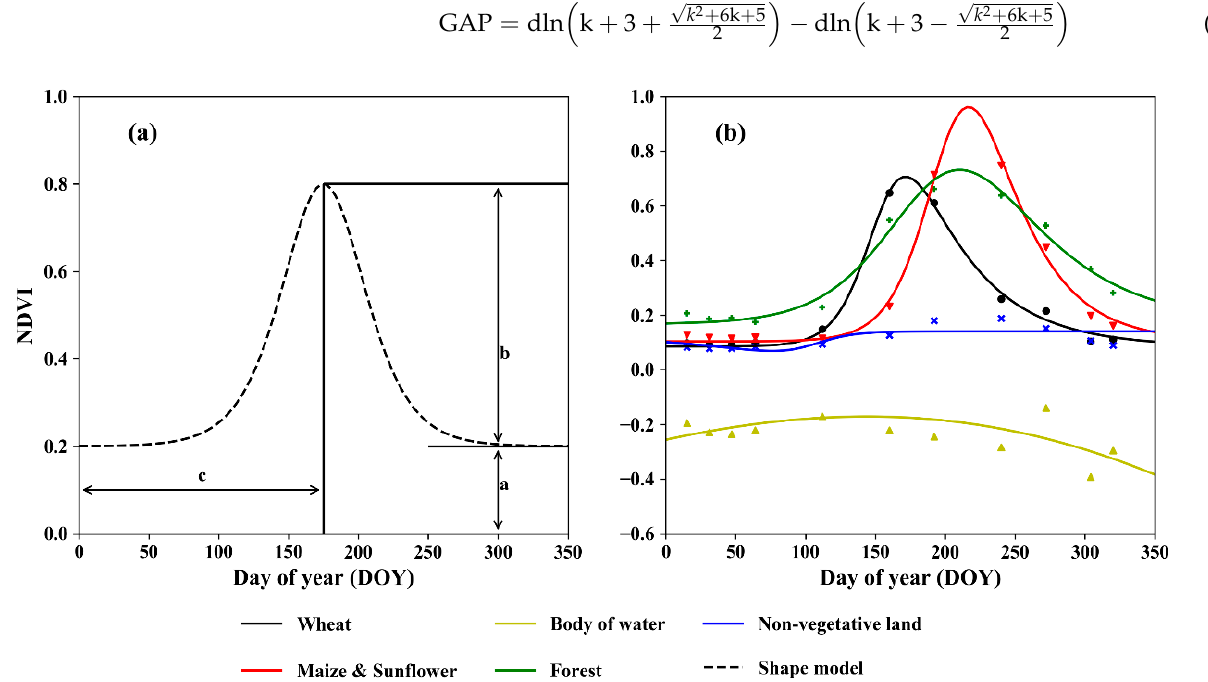
Figure 4. Schematic diagram of phenological metric extraction by shape-model-fitting method.